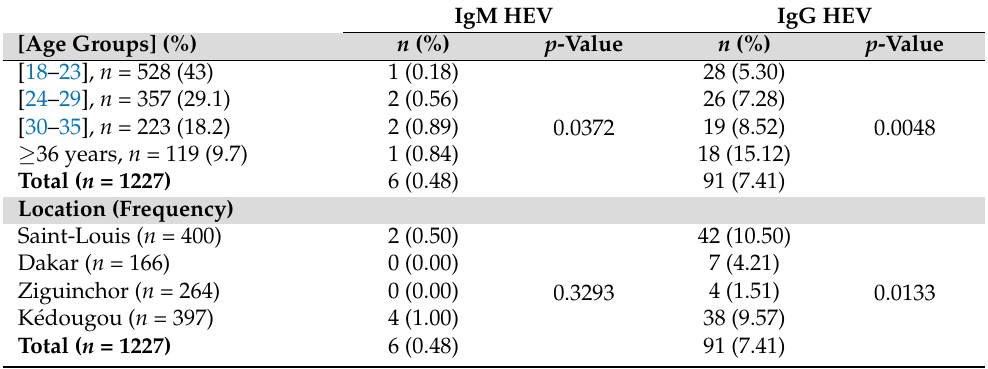
Table 2. Variability of HEV IgM and IgG serological markers according to age groups and localities.